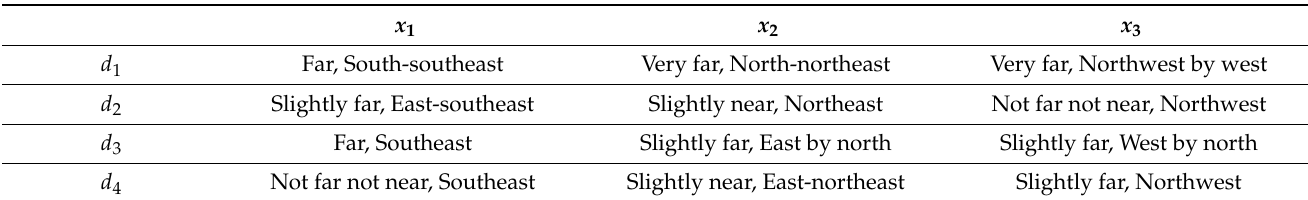
Table 2. Assessments.